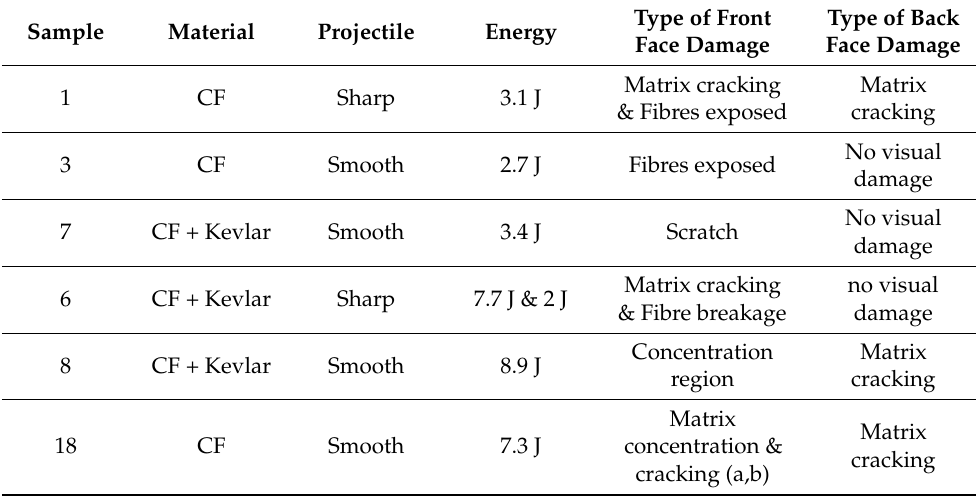
Table 5. Summary of the damages observed on composite panels under an inclined (28.5 ◦ ) impact.